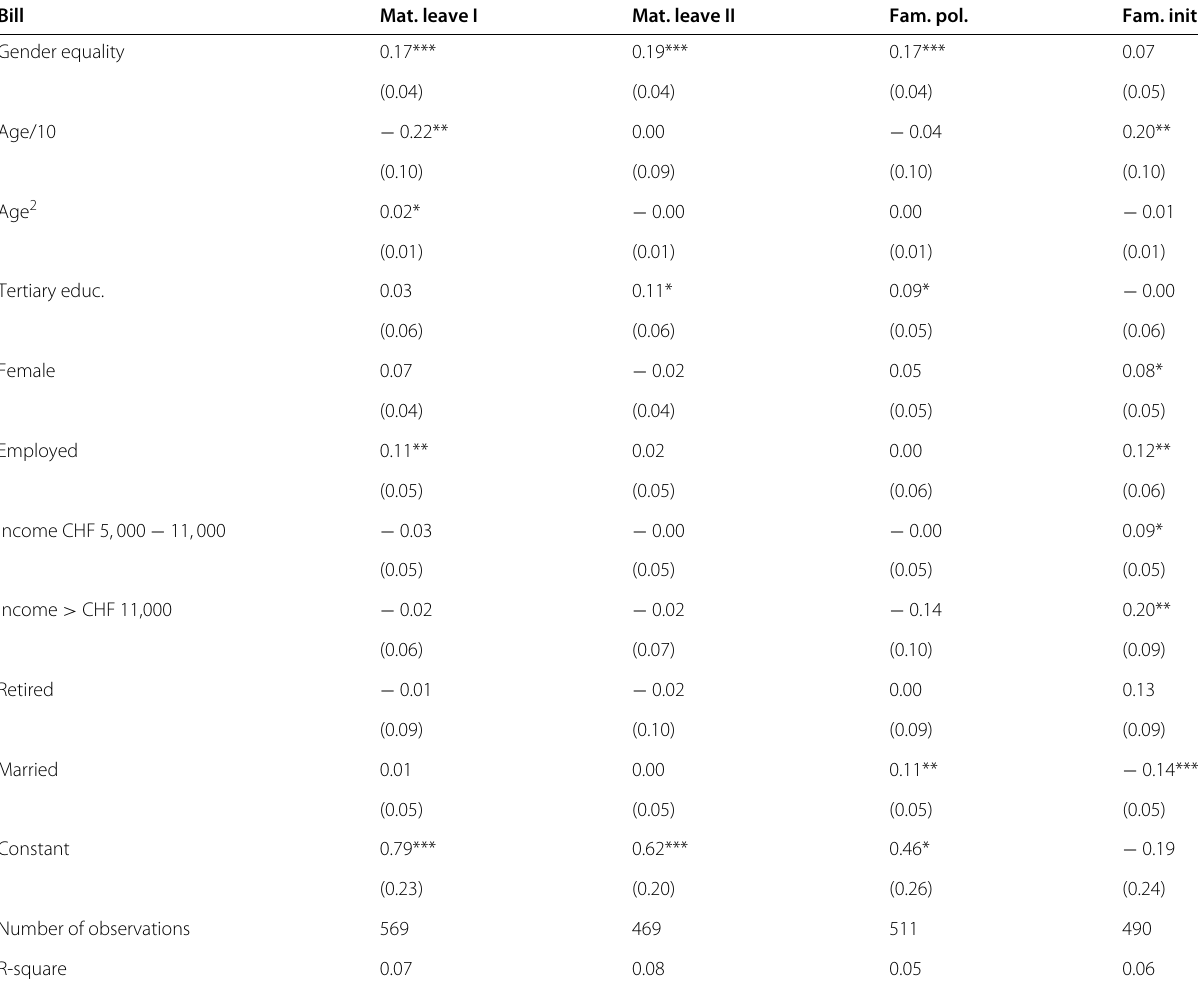
Table 6 Post-vote survey: correlation between the probability to vote yes and attitudes towards gender equality